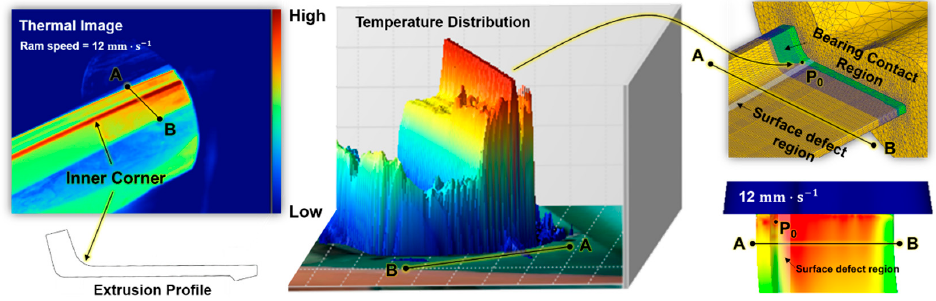
Figure 14. Temperature distribution measured using a Fluke Ti400 infrared camera.